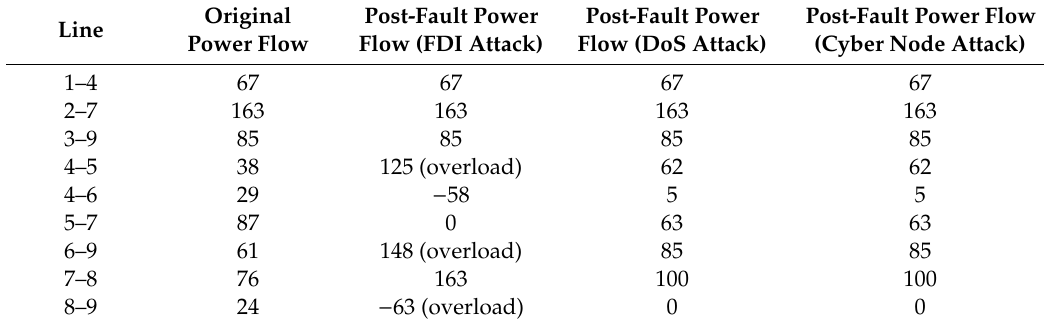
Table 3. The power flow transferring under cyber fault (MW).